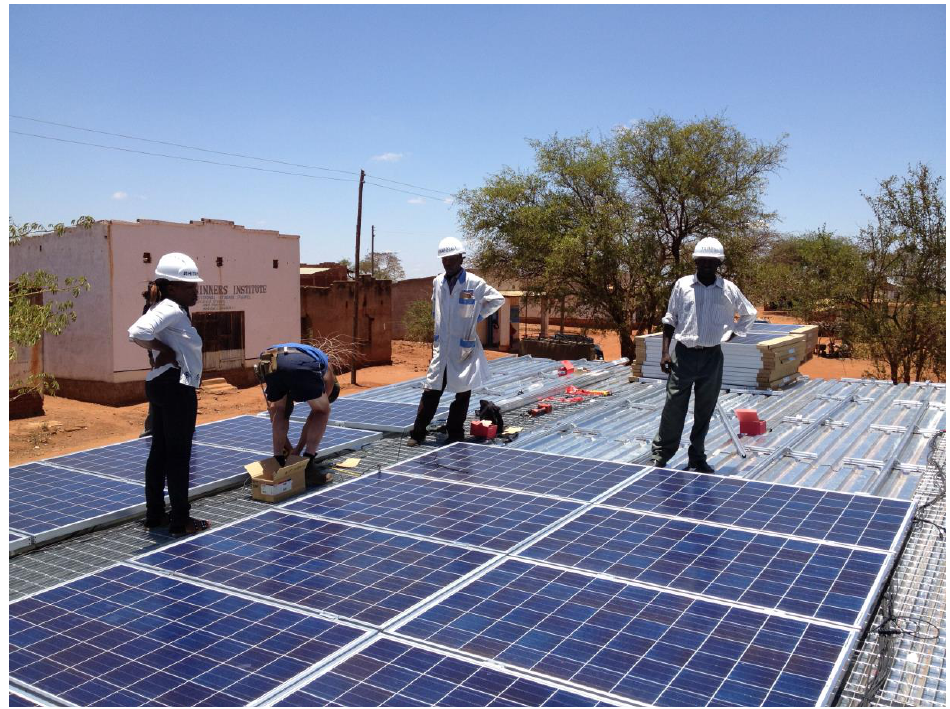
Figure 7. PV system on canopy where local engineers were trained as the project installation progressed and systems were commissioned.